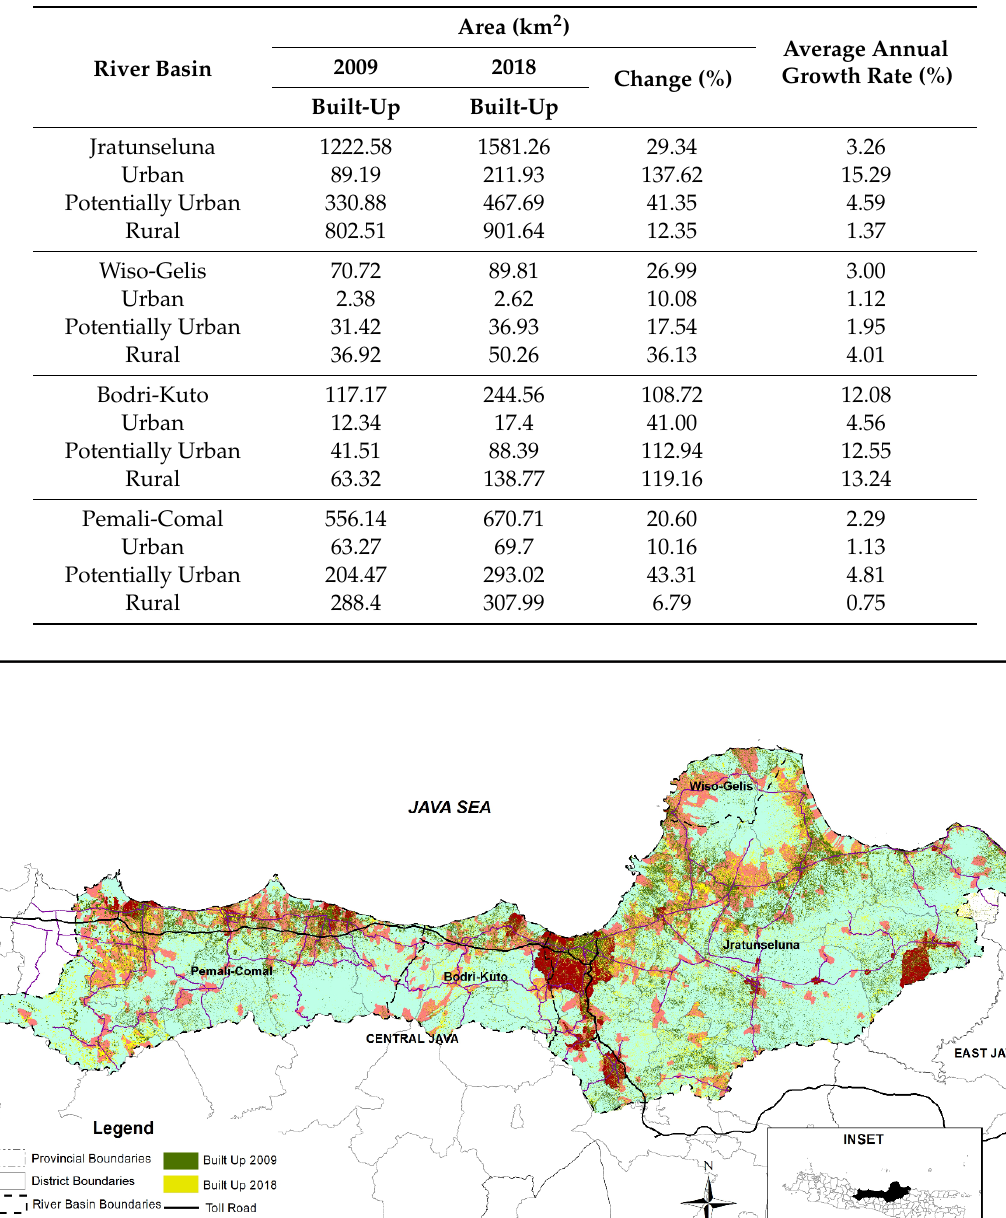
Table 6. Land Conversion in the Selected River Basins 2009–2018.